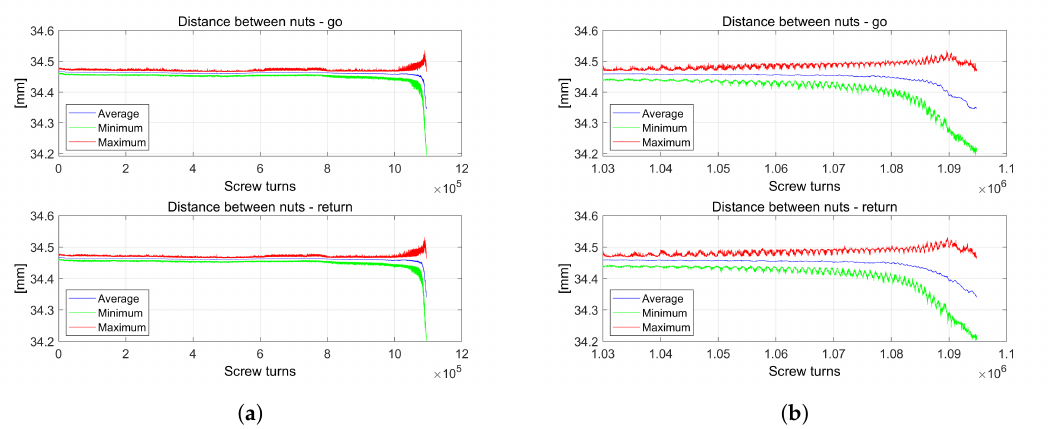
Figure 13. Distance between the two nuts. ( a ) Entire endurance test. ( b ) Enlargement of the final cycles. The distance variation between the two nuts, due to a change in the ambient temperature, also leads to an unavoidable alteration of the load applied to the screw. When a change occurs in the relative position between the nuts the spring preload is indeed also affected, due to the design of the mobile equipment. The higher the stiffness of the springs used to generate the load, the more amplified is this phenomenon. Figure 14 shows the trend of the total load acting on the nuts measured during the same test of Figure 13. A substantial change is identified at the end of the test, corresponding to the same cycle number at which the distance between the nuts changes in Figure 13. This happens since the force transmitted by the belleville spring to the nuts is altered due to a variation of the geometry of the system. It should be noted that, when a damage occurs, the loads on the two nuts change more significantly than what happened following the change in the ambient